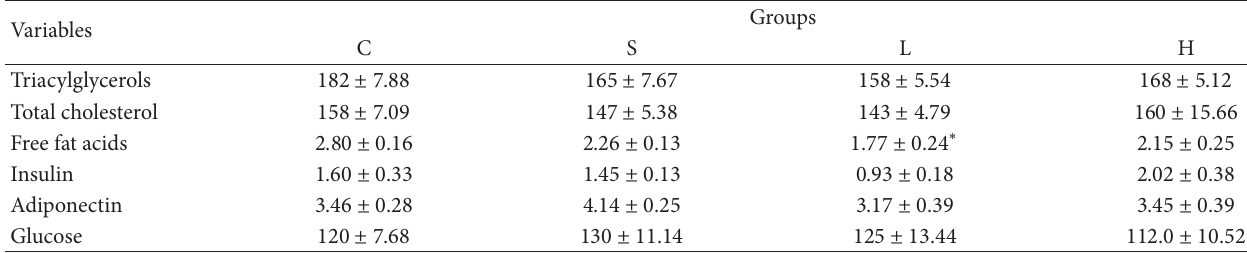
Table 4: Serum triacylglycerols (mg/dL), total cholesterol (mg/dL), free fat acids ( 𝜇 M), insulin (ng/mL), adiponectin ( 𝜇 g/mL) and glucose (mg/dL) of studied mice groups-(C) control group, (S) Soybean, (L) Lard and (H) Hydrogenated vegetable fat